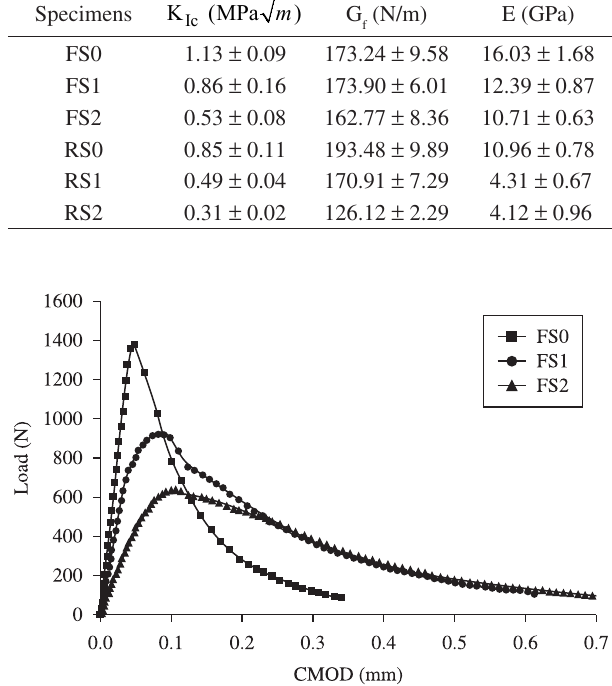
Figure 2. Load vs. CMOD test result of fresh sand textile reinforced polymer mortar.